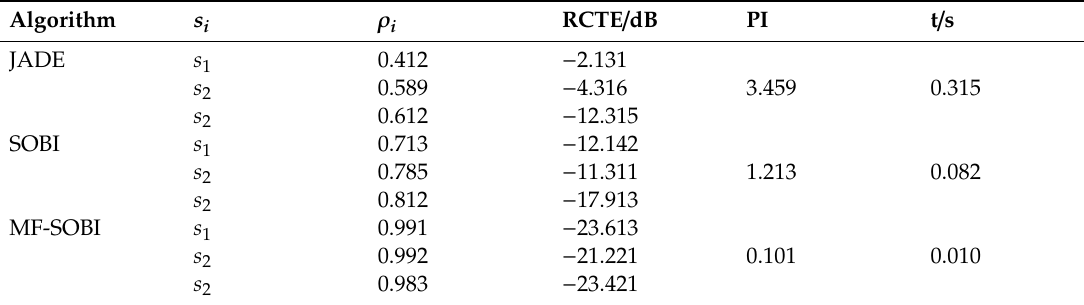
Table 1. Evaluation indexes’ comparison of blind source